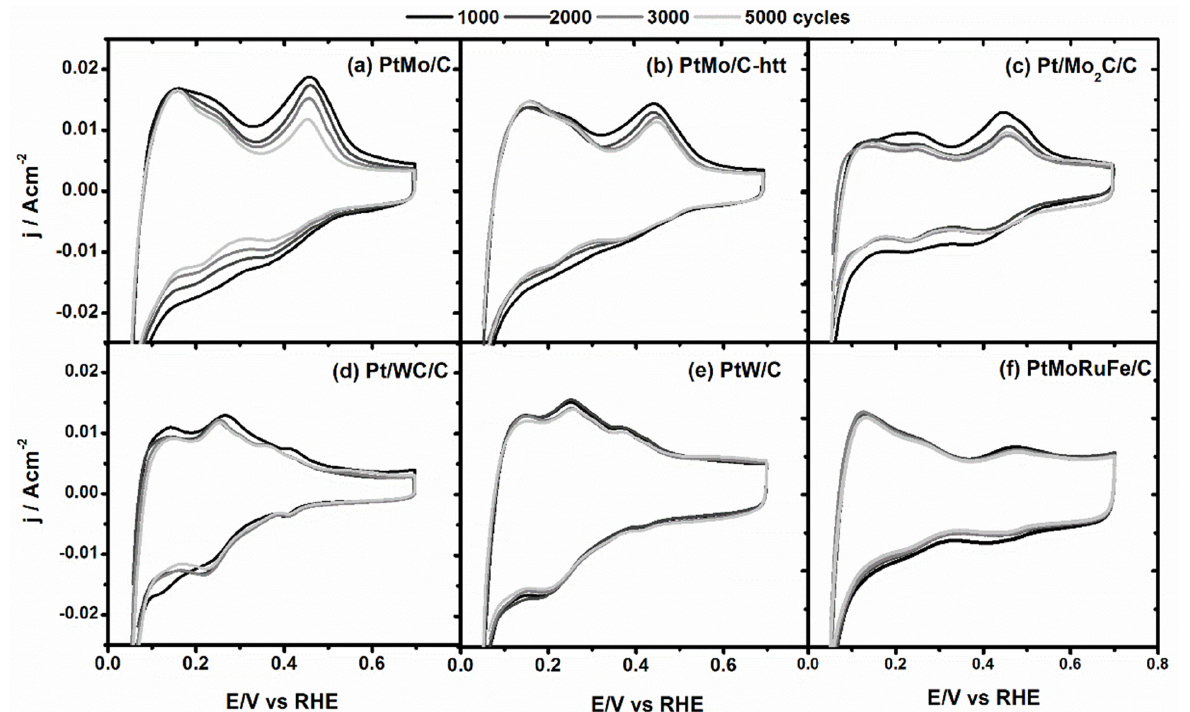
Figure 10 - Cyclic voltammograms obtained at 25 o C for various anodes composed of different catalysts; PtMo/C ( a ), PtMo/C-heat treated ( b ), Pt/Mo C/C ( c ), Pt/WC/C ( d ), PtW/C ( e ) and PtMoRuFe/C ( f ) recorded after 1000, 3000 and 5000 voltage AST cycles. 2 For these measurements, the anodes were supplied with Ar and the cathodes with pure H